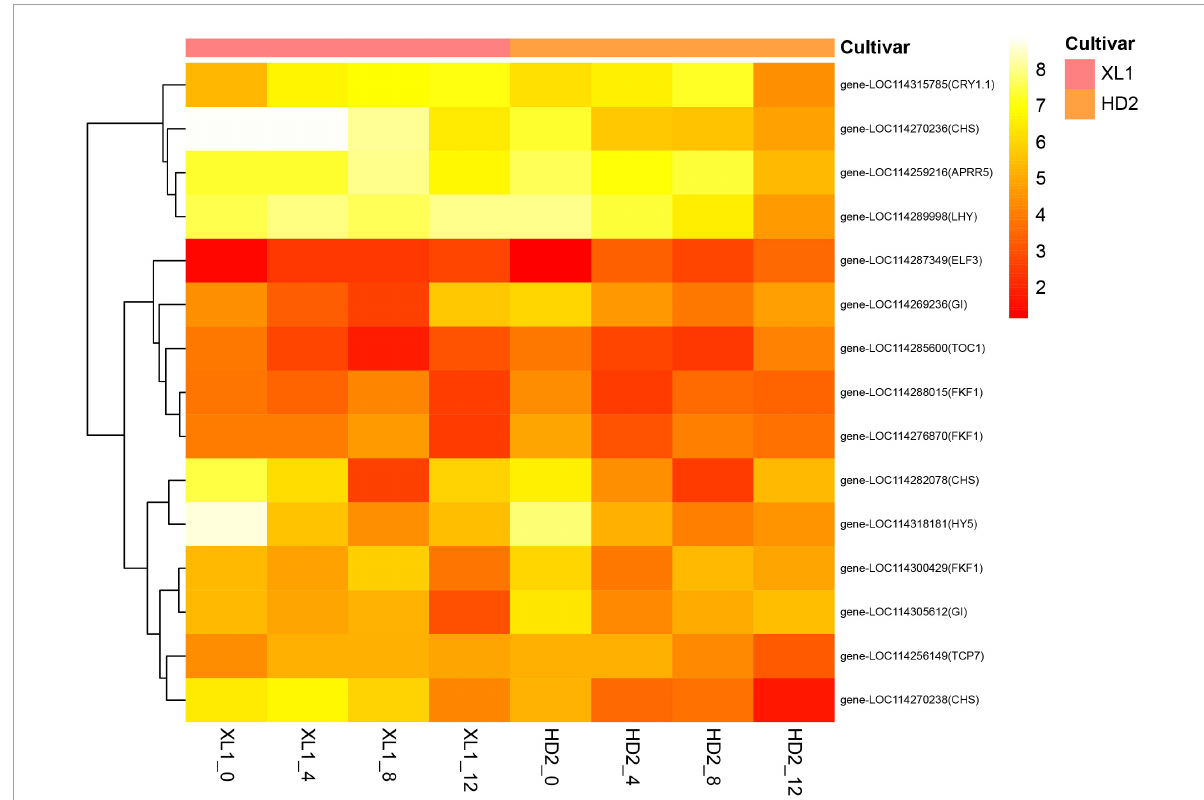
FIGURE6 The heatmap of differentially expressed genes (DEGs) involve in the Circadian rhythm - plant pathway. The heatmap was generated from the log 2 (FPKM + 1) of three replicates for each sample, and the values of clustering distance were “correlation” and the clustering algorithms was